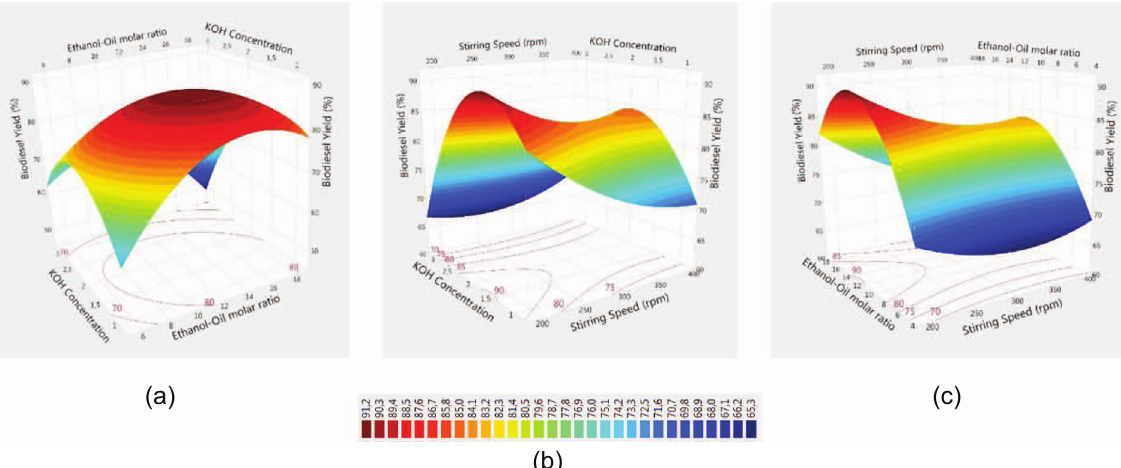
Fig. 3. Combined effects of: (a) ethanol – oil molar ratio and KOH concentration, (b) KOH concentration and stirring speed and (c) stirring speed and ethanol – oil molar ratio.